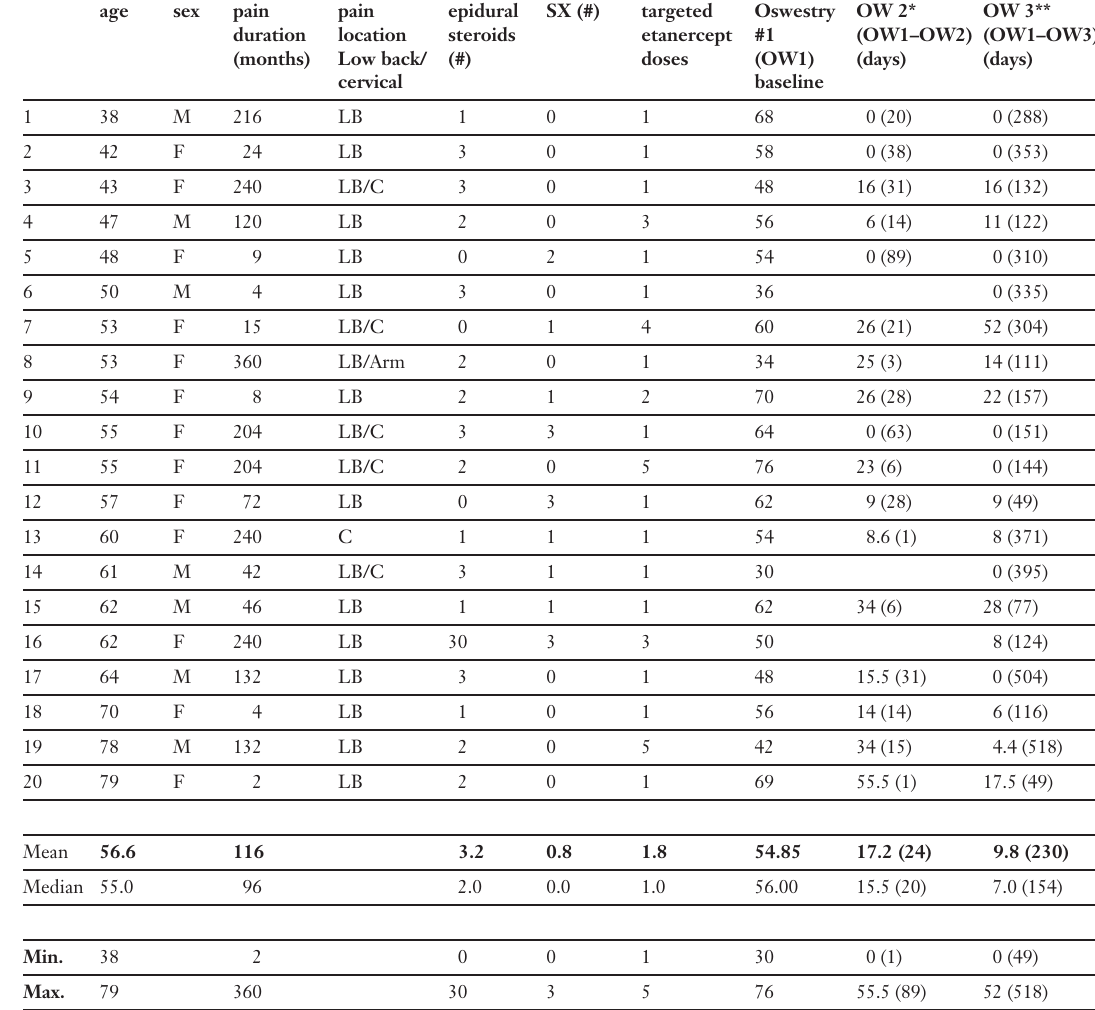
Targeted etanercept – results for 20-patient